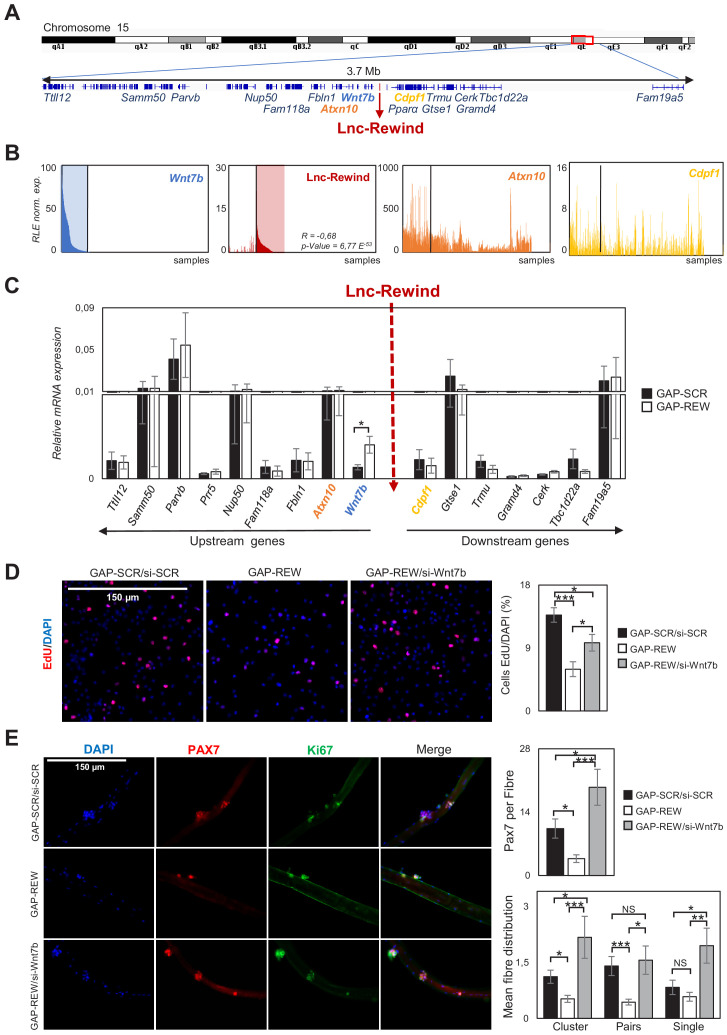
Lnc-Rewind and Wnt7b genes display opposite pattern of expression and a functional interplay.(A) Schematic UCSC visualization showing the Lnc-Rewind chromosome position and its neighbouring genes. (B) TSS usage analyses of Wnt7b, Lnc-Rewind, Atxn10, and Cdpf1 performed by using FANTOM5 (Phases 1 and 2) CAGE datasets. Each bar represents the Relative Logarithmic Expression (RLE) of the tag per million (TPM) values of the TSS of each gene in one sample (1196 samples). The order of the samples is the same in each of the histograms and shown in Figure 3—source data 1. R value represents the Spearman’s rank correlation coefficient between Lnc-Rewind and Wnt7b expression, and the p-value was calculated using the Spearman’s rank correlation test. (C) qRT-PCR quantification of Lnc-Rewind neighbouring genes in GAP-SCR versus GAP-REW treated. MuSCs-derived myoblasts. Data were normalized to Gapdh mRNA and represent the average ± SEM from four biological replicates. (D) Representative images of MuSC-derived myoblasts treated with GAP-SCR/si-SCR, GAP-REW, and GAP-REW/si-Wnt7b and incubated with EdU (red). Nuclei were visualized with DAPI, 4′,6-diamidino-2-phenylindole (blue). Histogram shows the percentage of EdU-positive cells on the total of DAPI-positive cells. Data are graphed as mean ± SEM; n = 5 mice. (E) Representative images of single muscle fibres treated with GAP-SCR/si-SCR, GAP-REW, and GAP-REW/si-Wnt7b from WT mice after 96 hr in culture, stained for Pax7 (red) and Ki67 (green). Nuclei were visualized with DAPI, 4′,6-diamidino-2-phenylindole (blue). Histogram (upper panel) shows the number of Pax7+ cells per fibre. Histograms (lower panel) represent the mean of the number of clusters (nuclei [n]: n > 2), pairs (n = 2), and single cells Pax7+ (n = 1) per fibre. Data represent the mean ± SEM; n = 5 mice. Data information: (C): *p<0.05, paired Student’s t-test. 3D and 3E: *p<0.05, **p<0.01, ***<0.001, one-way Anova with Tukey’s multiple comparison test.Figure 3—source data 1.5'CAGE TSS expression profile of Wnt7b, Lnc-Rewind, Atxn10 and Cdpf1 genes.Figure 3—source data 2.Source data for Figure 3.